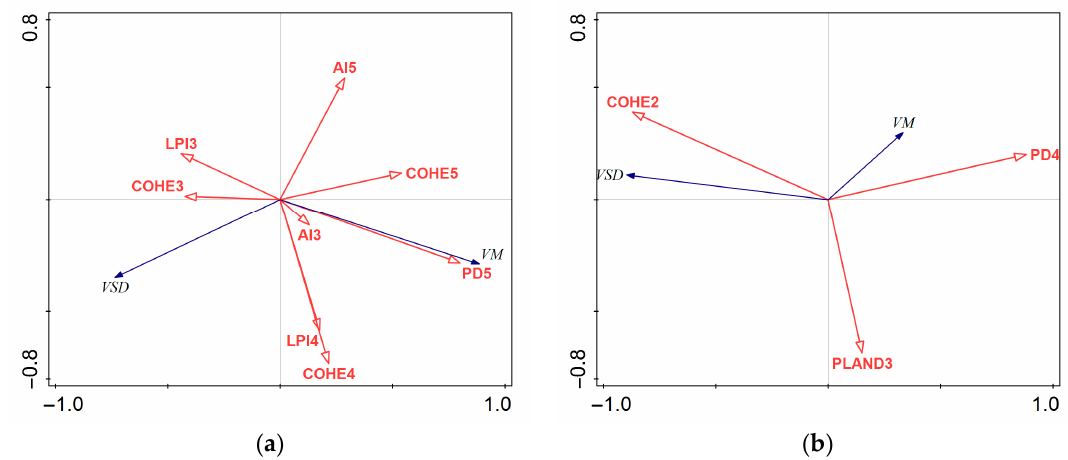
Figure 9. RDA ordination diagram with VM, VSD, and landscape metrics in the industrial area (COHESION was ab- breviated as COHE due to length limitation): ( a ) 2000; ( b ) 2012. (Note: PLAND = Percentage of Landscape, PD = Patch Density, LPI = Largest Patch Index, LSI = Landscape Shape Index, AI = Aggregation Index, CONTAG = Contagion Index, COHESION = Patch Cohesion Index. VM = volume mean, VSD = Volume Standard Deviation. 1 = Manmade coverage, 2 = Waterbody, 3 = Woodland, 4 = Grassland, 5 = Bare land).